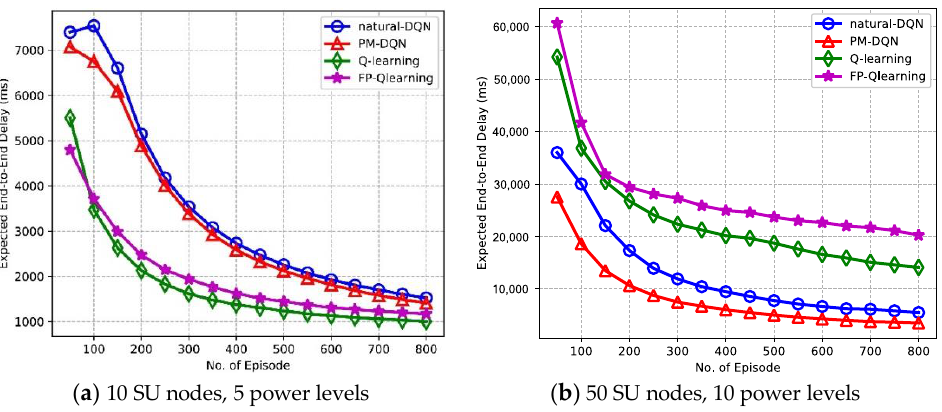
Figure 9. Expected end-to-end delay vs. the number of episodes.